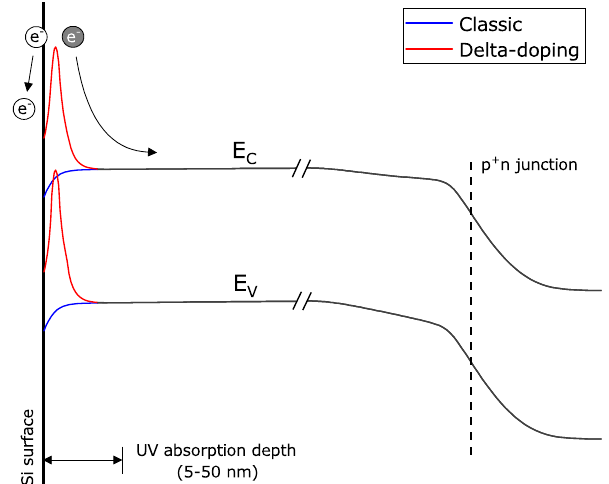
Figure 12. Simulation of the energy bands with and without delta-doping placed at the SPAD surface. Electrons generated past the delta-doping barrier drift toward the p + n junction. Only electrons absorbed too close to the surface are lost. Electrons in interface states are trapped at the surface, further reducing the SPAD dark